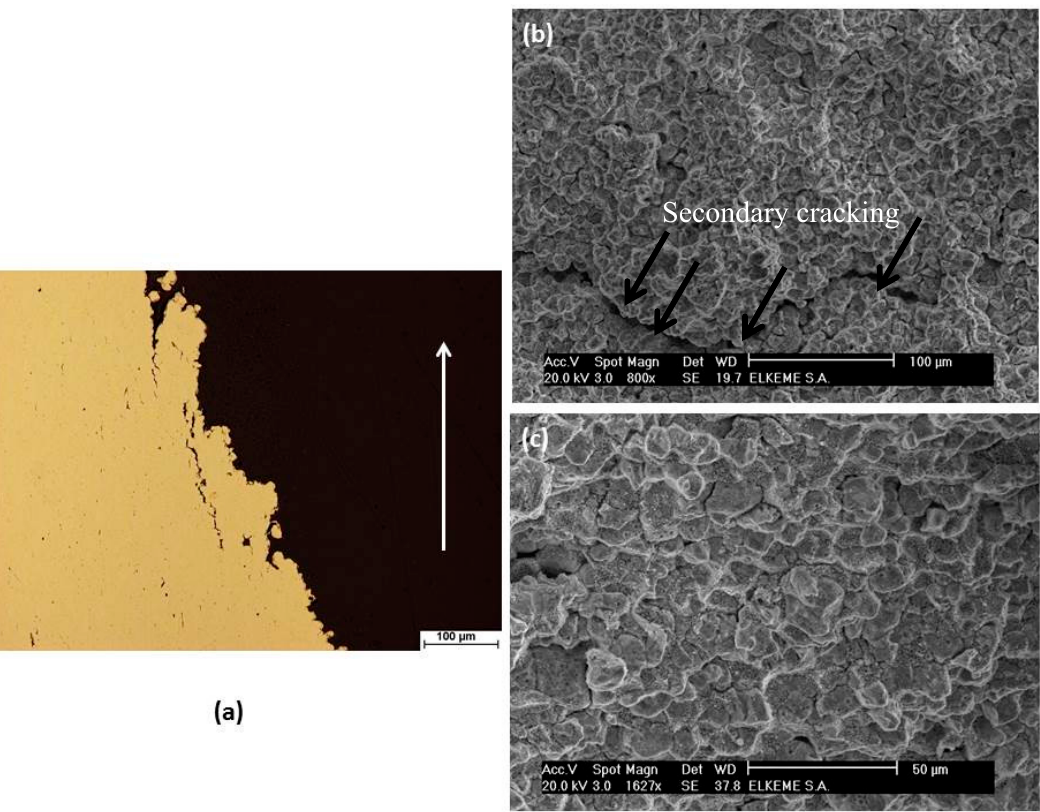
Figure 9. ( a ) Optical micrograph (as-polished/bright field illumination) showing extensive surface cracking occurred in extruded brass CW614N-CuZn39Pb3 (hexagonal rod of 6 mm across flats), ( b ) and ( c ) scanning electron microscope (SEM) fractographs (secondary electron imaging) showing a typical intergranular fracture mode and secondary, transverse cracking due to overheating. The white arrow shows the extrusion direction. This failure case history was presented in detail in Ref. [32].